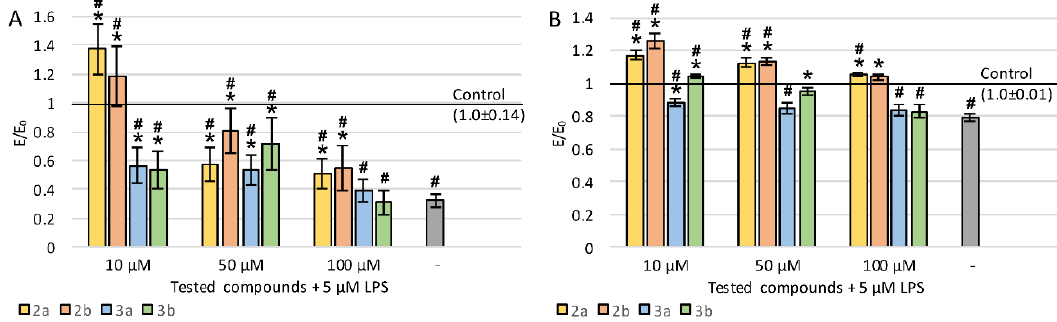
Figure 4. E ff ect of tested compounds on neurites in PC12 cells preincubated with LPS: ( A ) average length Figure 4. Effect of tested compounds on neurites in PC12 cells preincubated with LPS: A ) average of neurites, ( B ) neurite outgrowth; Control—cell culture incubated without LPS and tested substances; length of neurites, B ) neurite outgrowth; Control—cell culture incubated without LPS and tested * p < 0.05—significant di ff erence compared to control preincubated with LPS; # p < 0.05—significant substances; * p < 0.05—significant difference compared to control preincubated with LPS; # p < 0.05— di ff erence compared to the negative control without significant difference compared to the negative control without LPS.